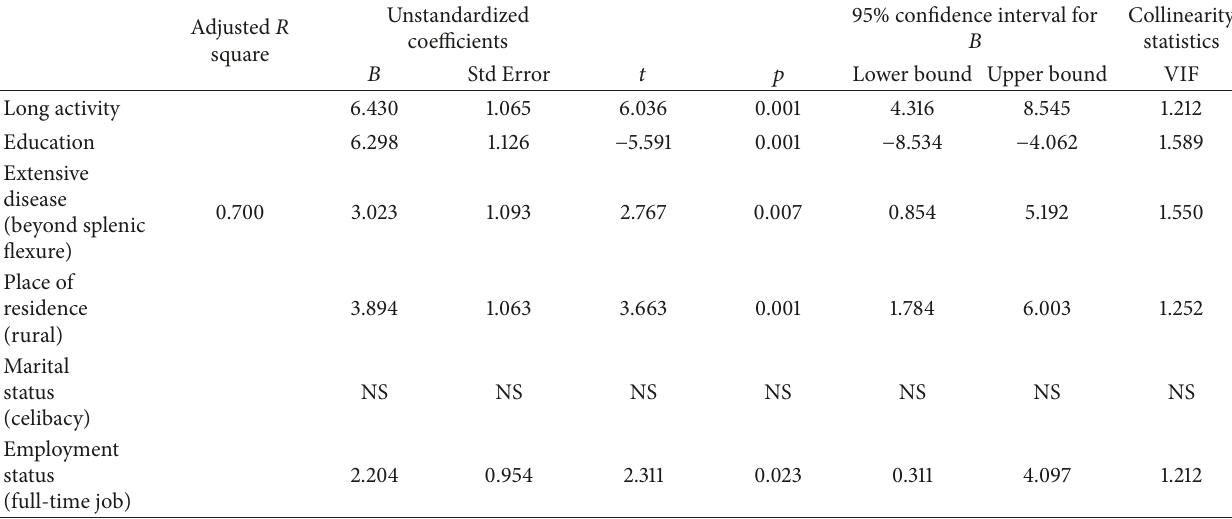
Table 6: Predictors for increased overall disability among population characteristics on the basis of multiple linear regression in patients with ulcerative